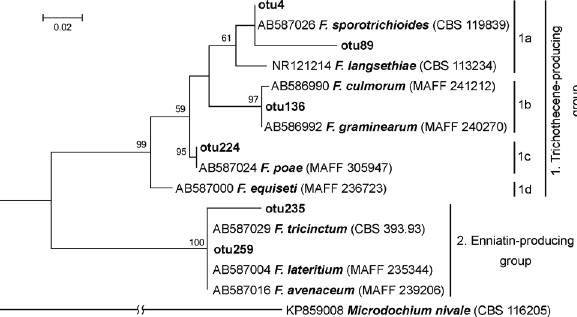
Figure 4 Maximum likelihood tree of OTUs related to the Fusarium genus. Bootstrap values based on 1000 replicates.